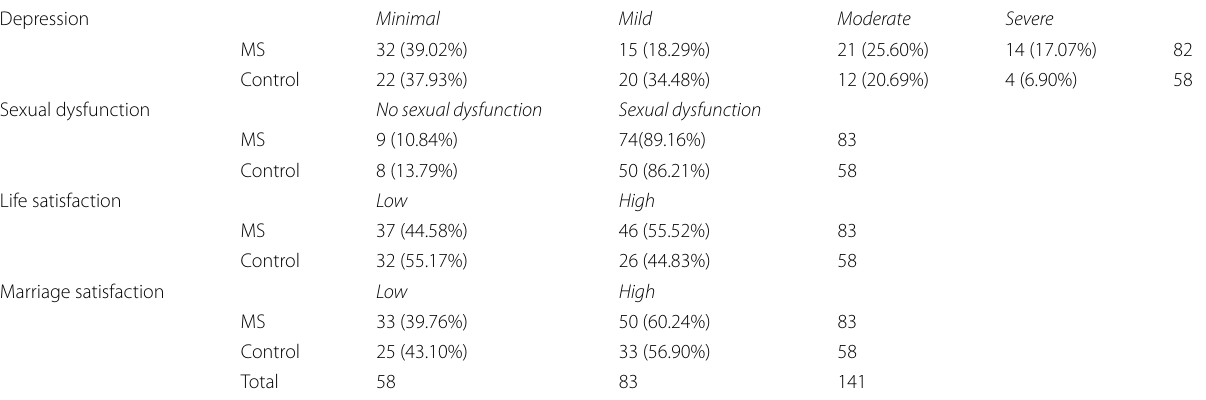
Table 2 Frequency result of scales